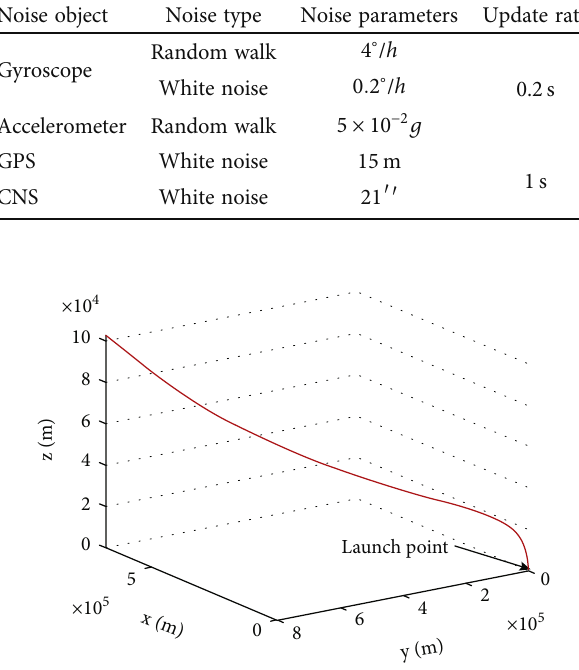
Figure 3: Flight path of aerospace